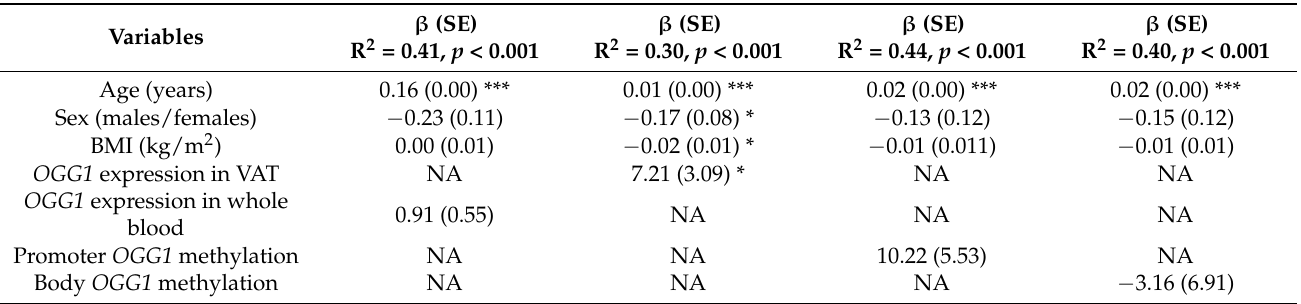
Table 2. Multiple regression analysis of the OGG1 gene as a predictor of the risk of colorectal cancer